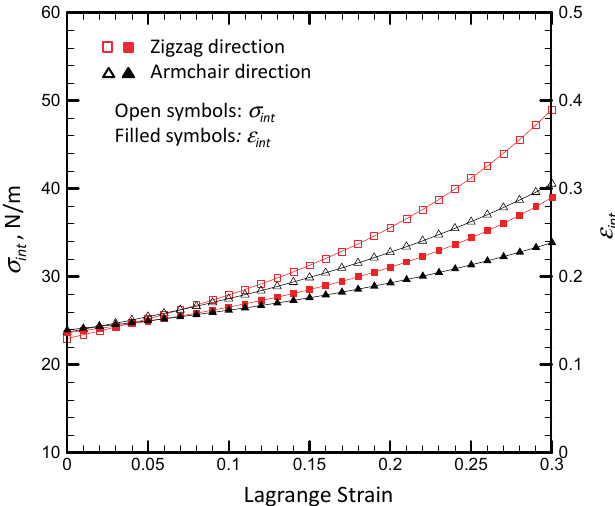
Figure 5. Intrinsic strength σ calculated from Equation